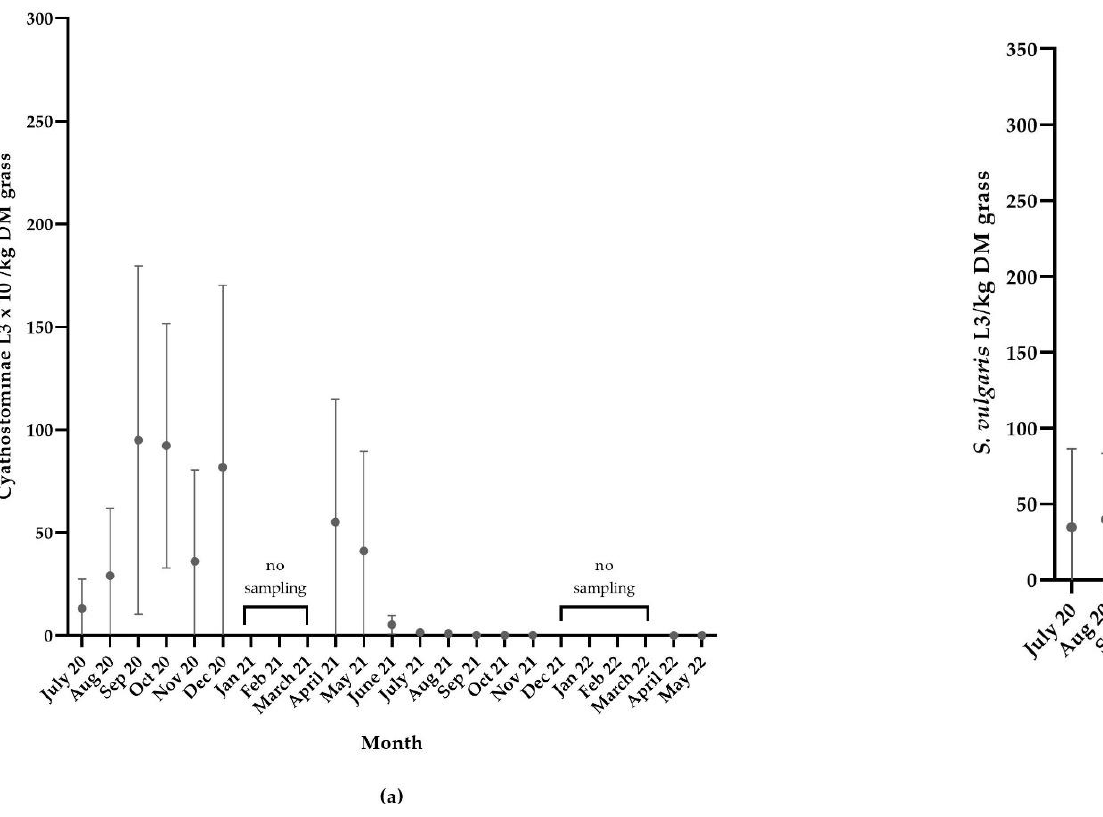
Figure 12. Scatter plot showing: ( a ) Cyathostominae larval yield (mean ( ± SD) L3 × 10 2 /kg DM grass) and ( b ) S. vulgaris larval yield (mean ( ± SD) L3/kg DM grass) during the overwintering study. Note the different scales on the y-axis for Cyathostominae (L3 × 10 2 /kg DM) and S. vulgaris (L3/kg DM).